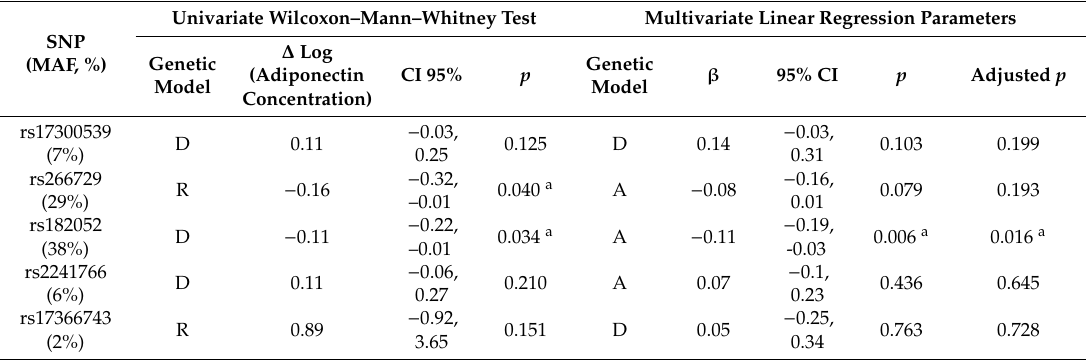
Table 4. Univariate nonparametric test and multivariate linear regression analysis of associations of the SNPs of the ADIPOQ gene with logarithm of serum concentration of